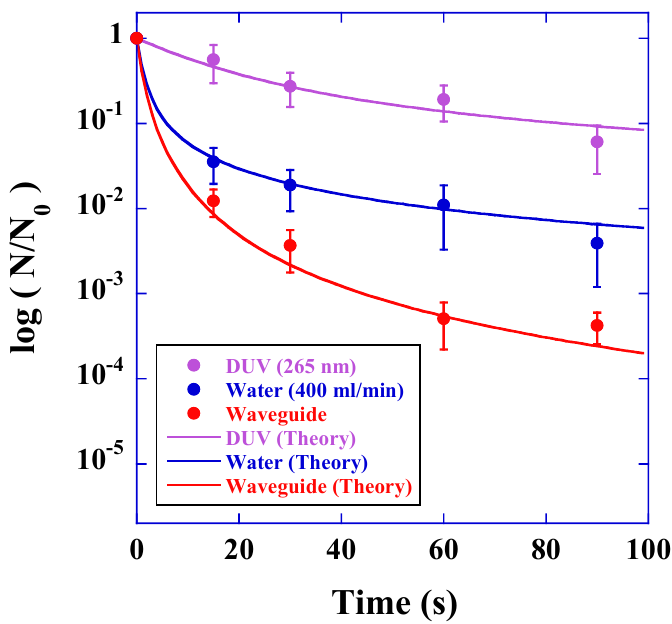
Figure 4. The relative ratio of the decrease in CFU for S. warneri (disinfected-CFU divided by control-CFU) achieved with DUV light irradiation with an intensity of 57 µ W/cm 2 (purple circles), running water treatment with a flow rate of 400 mL/min (blue circles), and water-waveguide treatment with an intensity of 143 µ W/cm 2 and a flow rate of 400 mL/min (red circles). The theoretically calculated lines express the rate of the decrease in CFU by DUV irradiation (purple line), running water treatment (blue line), and water-waveguide treatment (red line).